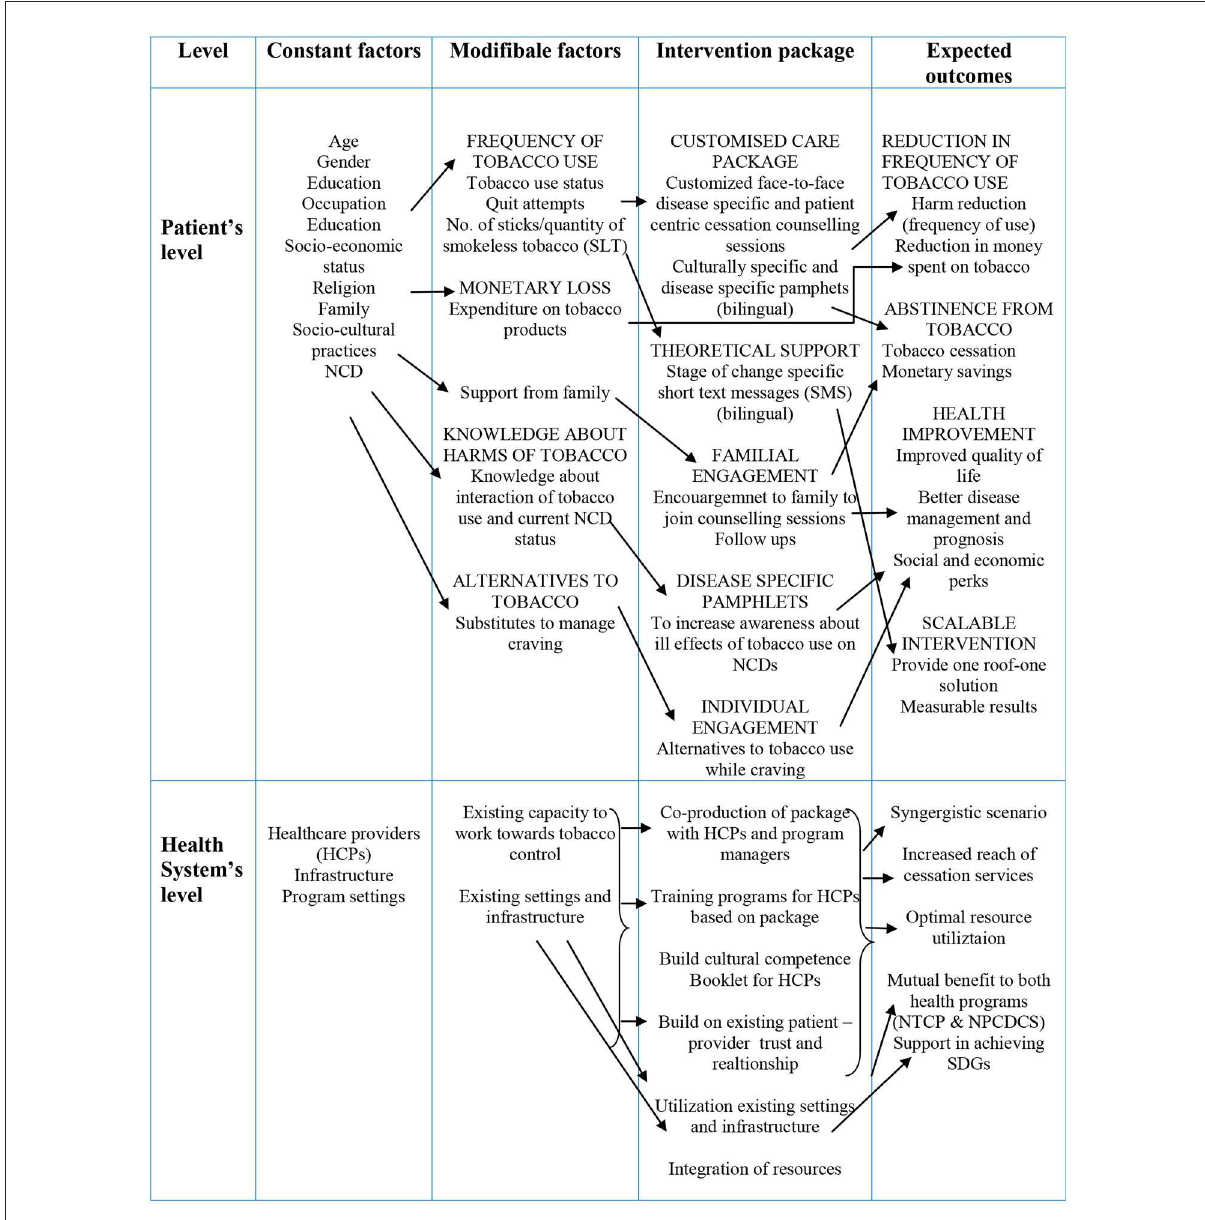
FIGURE3 Conceptual